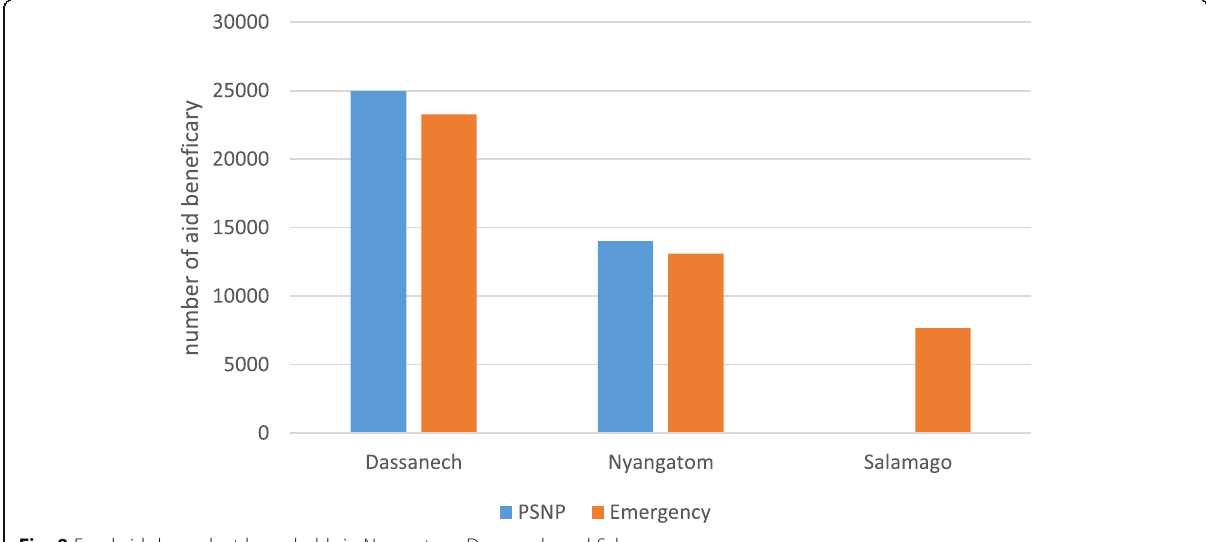
Fig. 8 Food aid-dependent households in Nyangatom, Dassanech, and